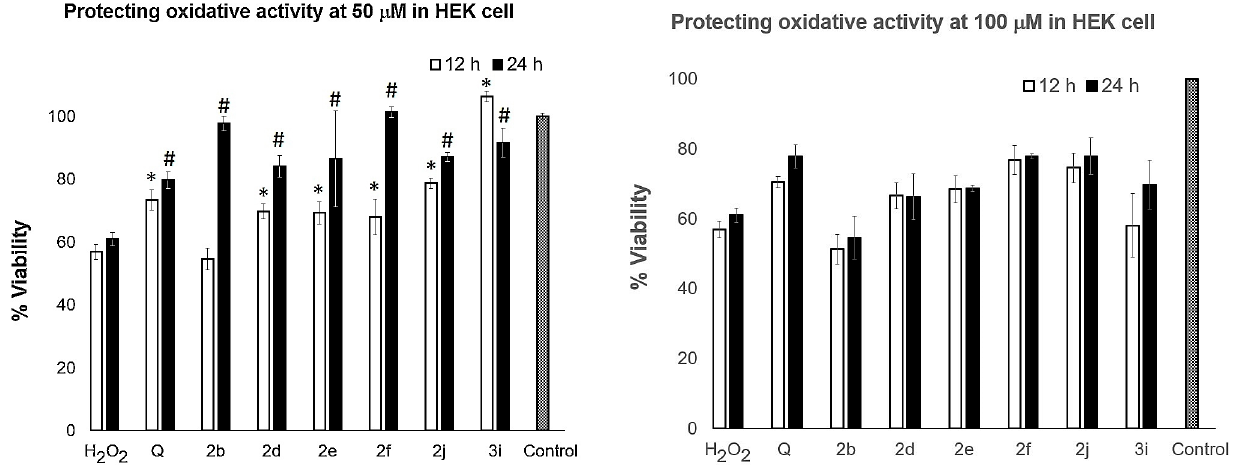
Figure 3. Protective effect of synthesized compounds on H 2 O 2 -induced cytotoxicity in cultured HEK cells (means ± SD, n = 3). Data (cell viability, measured by the MTT assay) were expressed as a percentage of the control group, which is 100%. The results were calculated from three independent experiments and are shown as mean ± SD. Compared to the H 2 O 2 model group, the p values were calculated using a one-way ANOVA with Tukey (Turkey HSD) multiple comparison analysis; * p < 0.05 at 12 h treatment, # p < 0.05 at 24 h treatment.